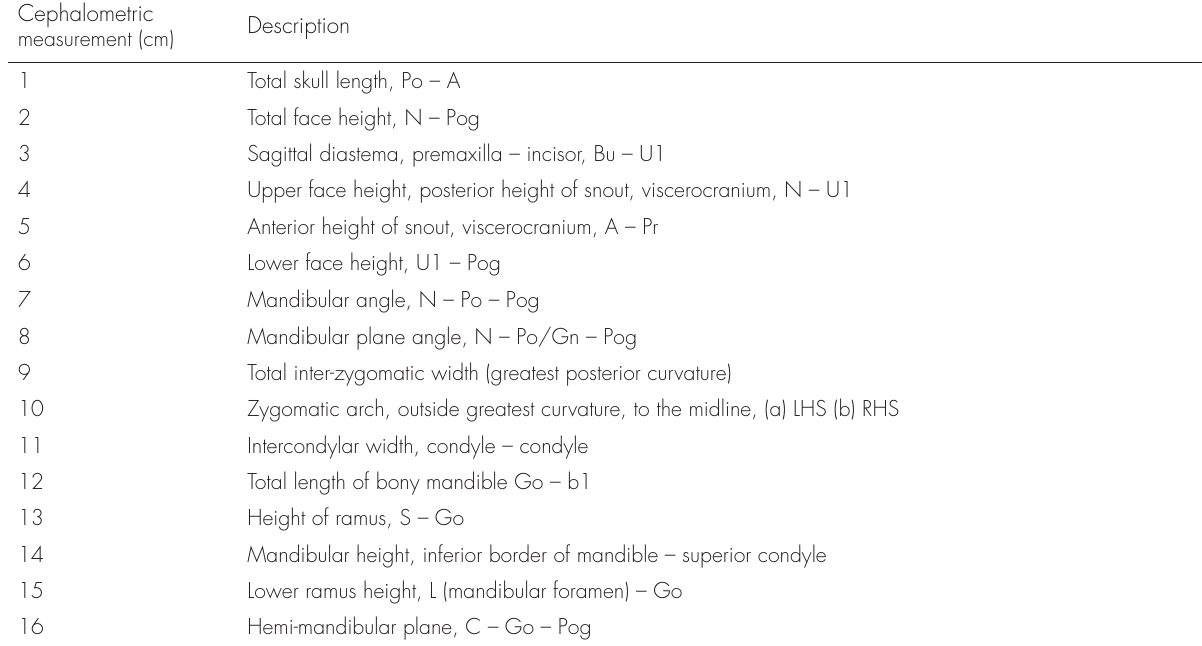
Table II. Facial landmark